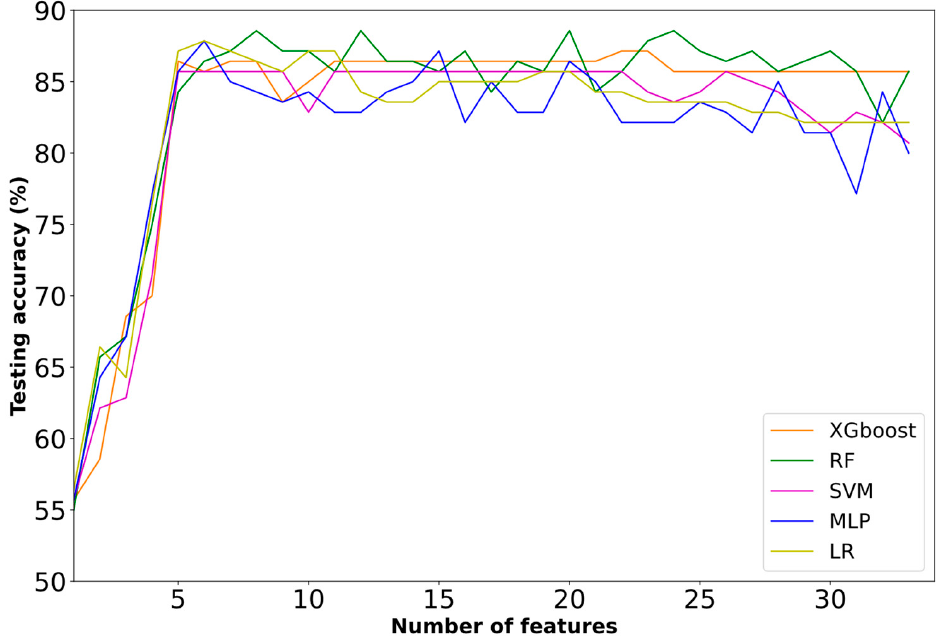
Figure 2. Learning curves based on the testing performance of the first approach.